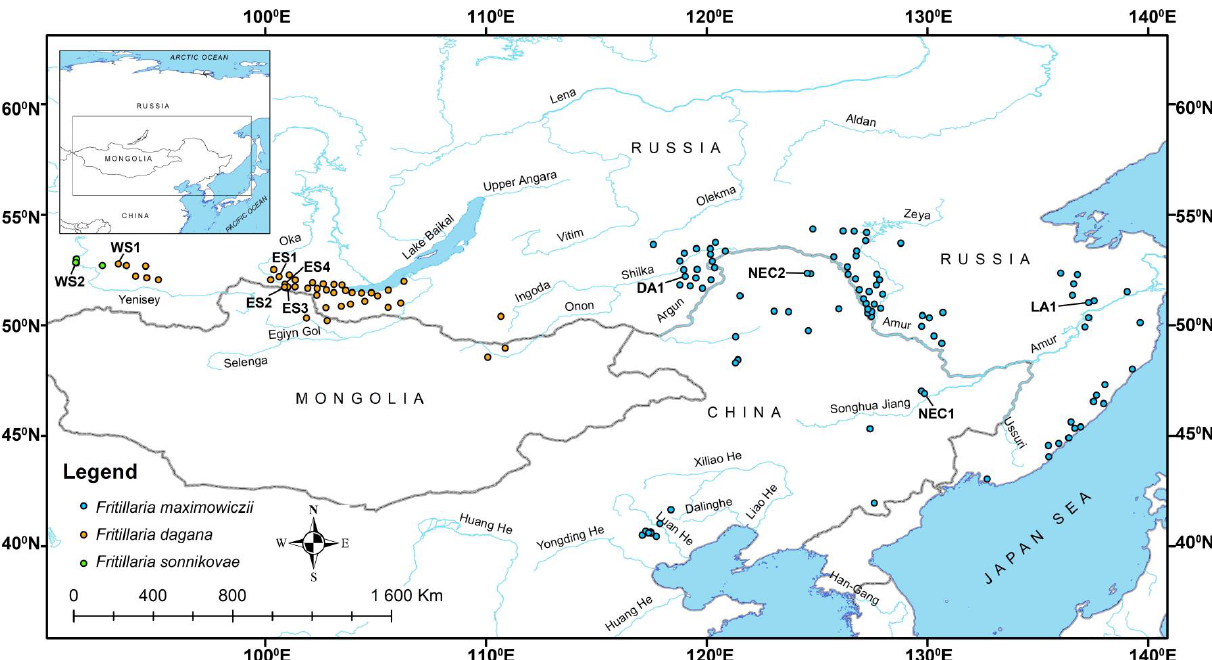
Figure 1. The map of the three Fritillaria species ’ distribution and sample collection sites for phylogenetic analysis. The abbreviated locality names and numbers are the same as those listed in the figures and tables further in the paper. The localities ES1-ES2 (the Eastern Sayan Mountains), WS1 and WS2 (the Western Sayan Mountains), and DA1 (Argun Dahuria) correspond to sampling sites for DNA analysis carried out in the present study; the localities LA1 (the lower Amur river) and NEC1 and NEC2 (NE China) correspond to the sequences obtained from GenBank and are indicated according to the previously published voucher information [4,6,7,9]. The map was drawn using QGIS 3.10, datum WGS84.